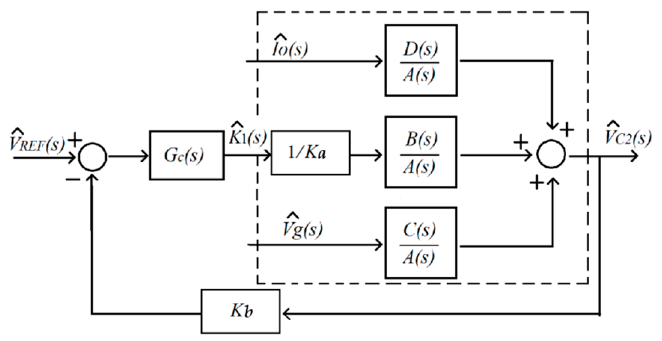
Figure 9. Block diagram of the output voltage regulation loop.